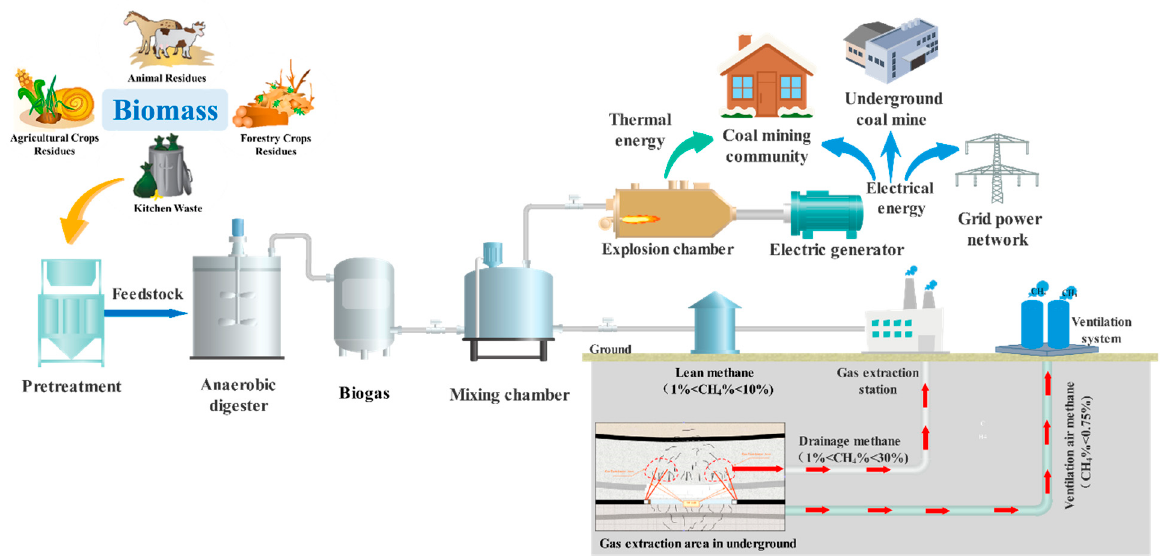
Figure 4. Co-production system with lean methane and biogas for power generation.